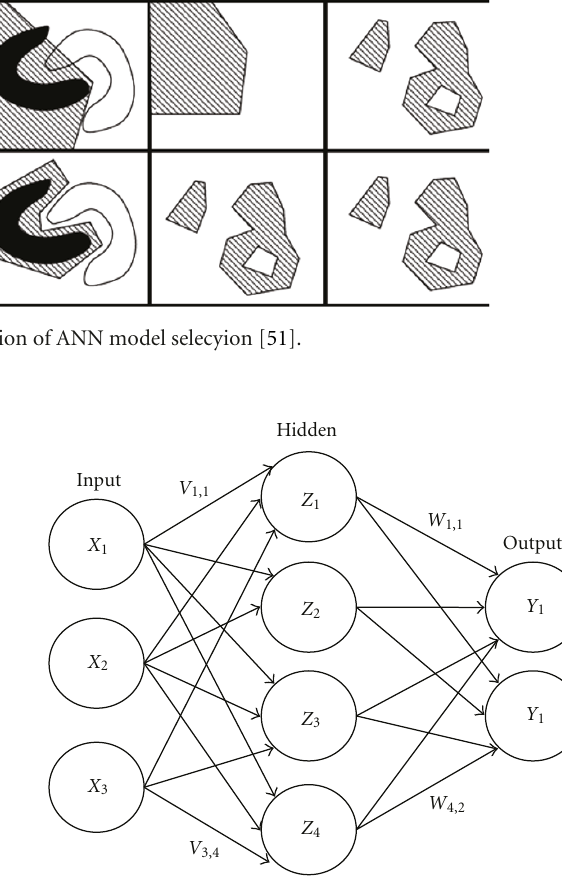
Figure 3: Simple Three-layered Neural Network Structure